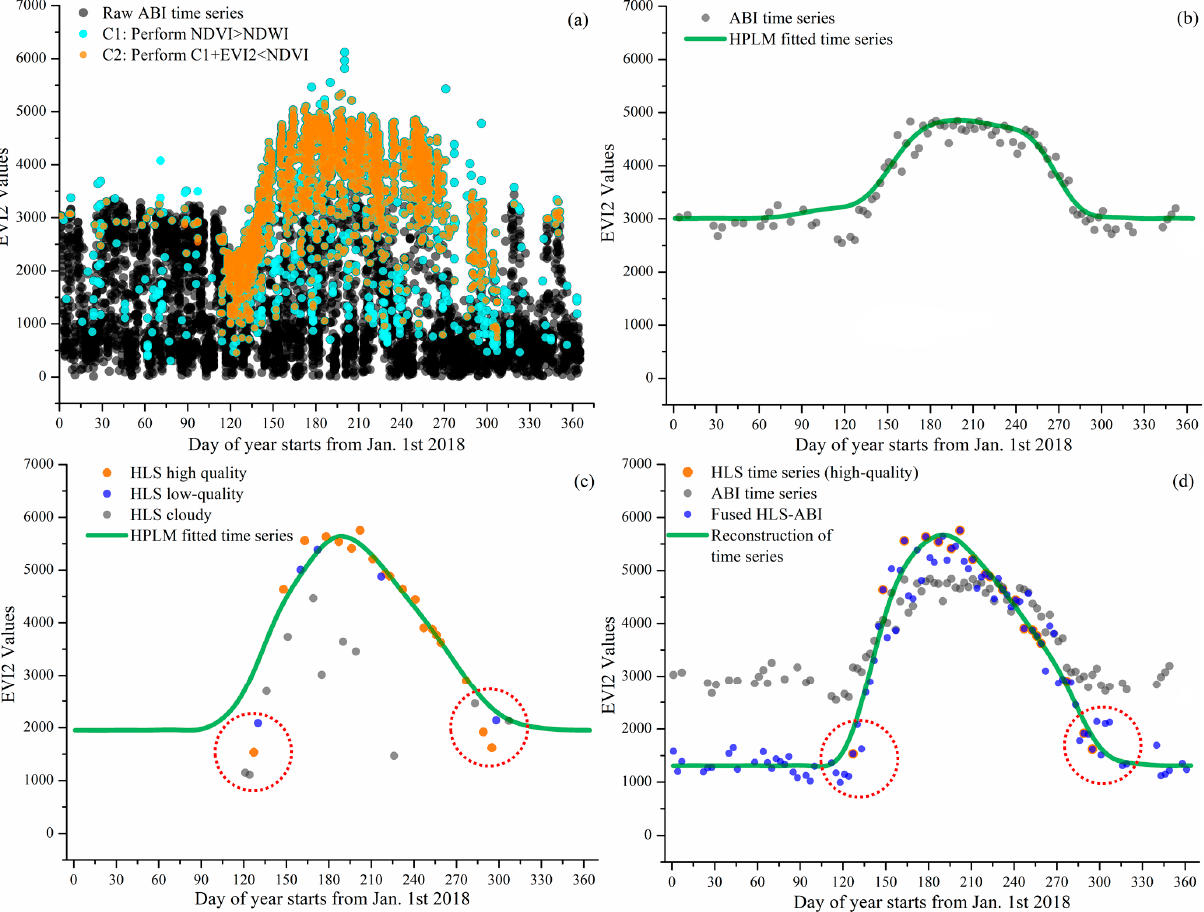
Figure 4. Reconstruction of wetland HLS-ABI time series in a wetland pixel. ( a ) denotes the noise reduction process for selecting high-quality ABI observations from raw ABI observations, where the black dots are the results of overlaps from multiple gray dots. ( b – d ) present the reconstruction of EVI2 temporal trajectories from ABI, HLS, and HLS-ABI, respectively. The value in y-axis is multiplied by 10,000.